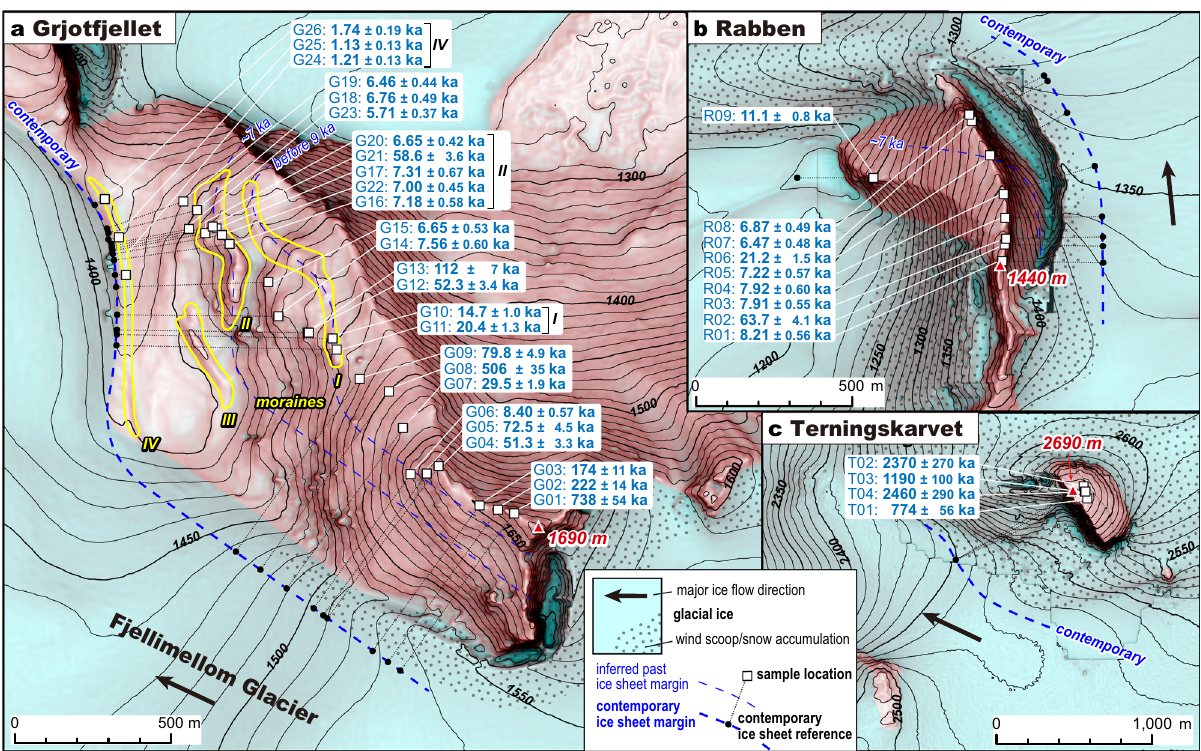
Fig. 2 Detailed topographic maps of Grjotfjellet. Locations of samples and their 10 Be exposure ages from Grjotfjellet ( a ), Rabben ( b ), and Terningskarvet ( c ) are shown along with corresponding elevation reference points on the contemporary ice sheet. Well-de fi ned moraine ridges at Grjotfjellet are outlined by yellow lines with Roman numerals indicating moraine numbers (I – IV). 10 Be exposure ages of erratic samples collected from the moraine ridges are labeled by their corresponding moraine numbers. Blue dashed lines indicate contemporary (bold) and inferred past (thin) locations of the ice sheet margin. Topographic contours are in meters above sea level (m a.s.l.), based on the 2 m-resolution Reference Elevation Model of Antarctica (REMA) 53 and Earth Gravitational Model 2008 54 . The background image is a morphometric protection index red relief image map 83 produced from the same DEM with glacial- ice areas shaded in half-transparent blue. See Supplementary Data 1 and 2 and Supplementary Note 1 for more details on the samples, their exposure ages, and age